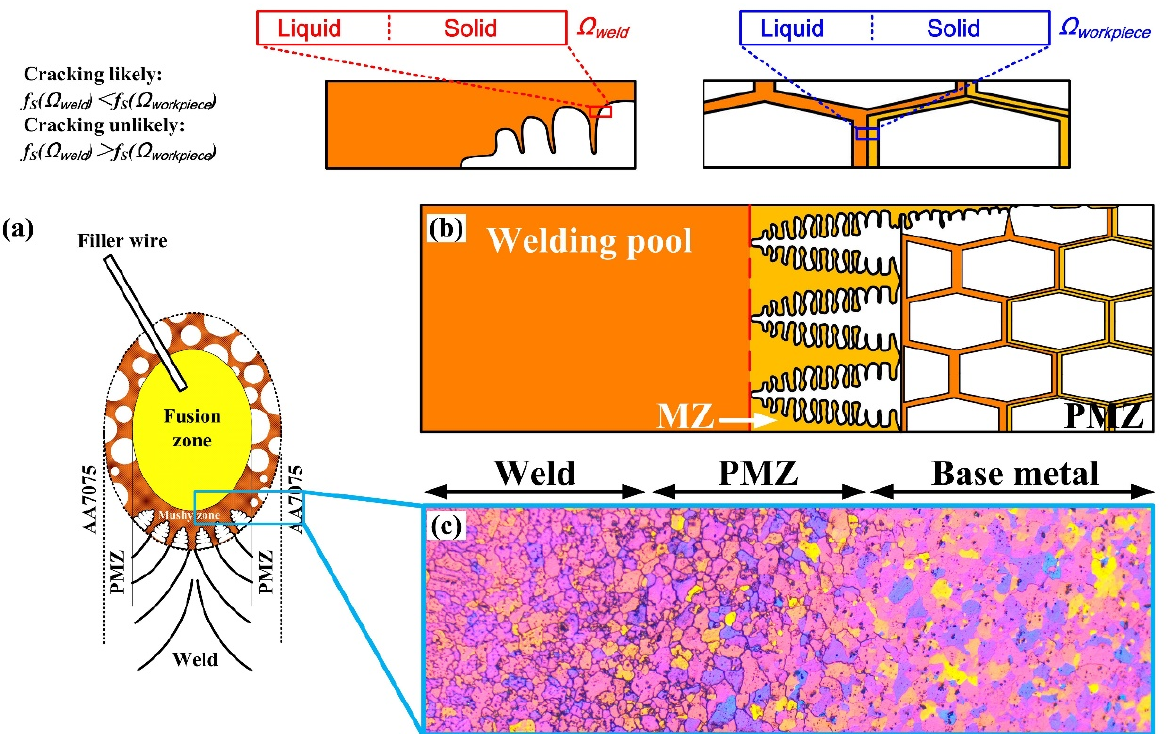
Figure 3. Schematic of analyzing liquation cracking susceptibility by using volume elements Ω : ( a ) Sub-divisions of the welds; ( b ) magnification of the rectangle area in ( a ); ( c ) CM figure of AA7075 GTAW joint of corresponding area.